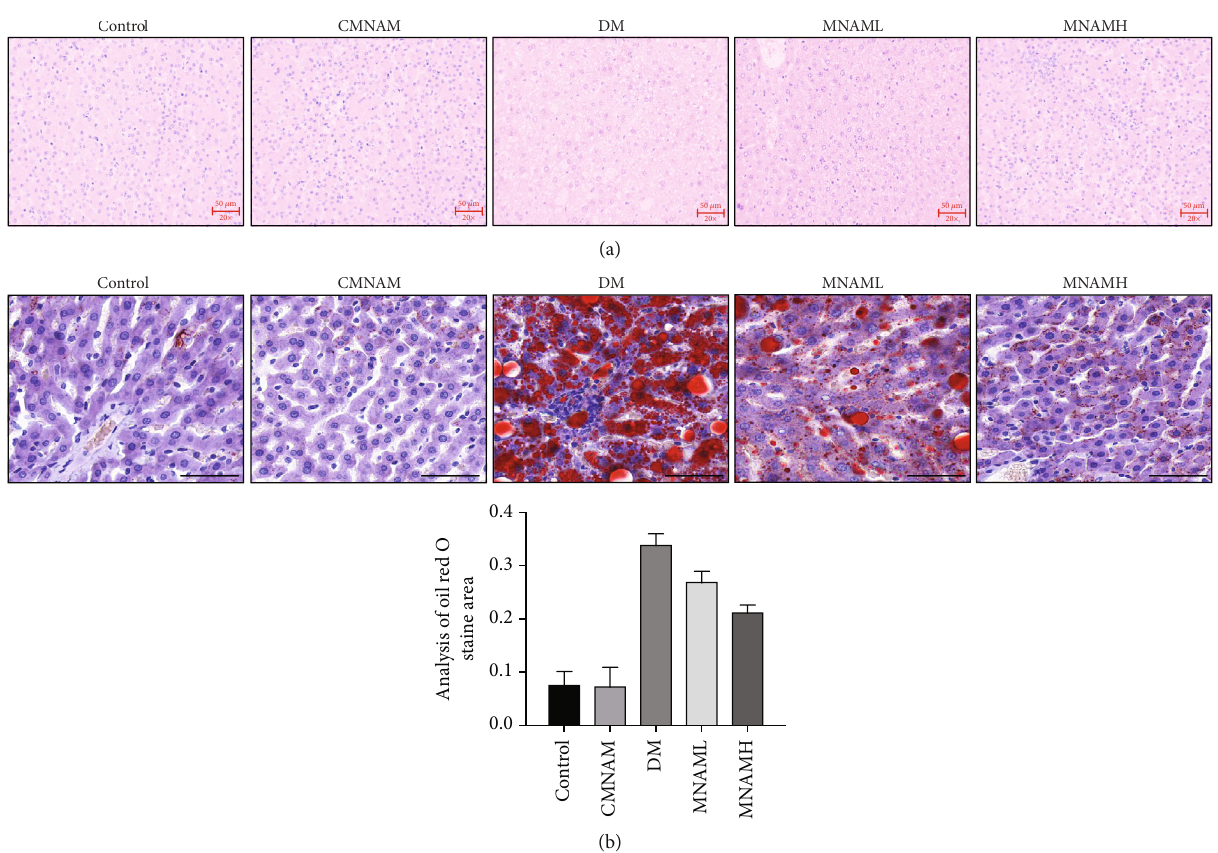
Figure 3: MNAM e ff ectively improves liver morphology and reduces lipid accumulation in the liver ( n = 10 ). (a) HE staining ( scale bar = 50 μ m ); (b) oil red staining ( scalebar = 50 μ m